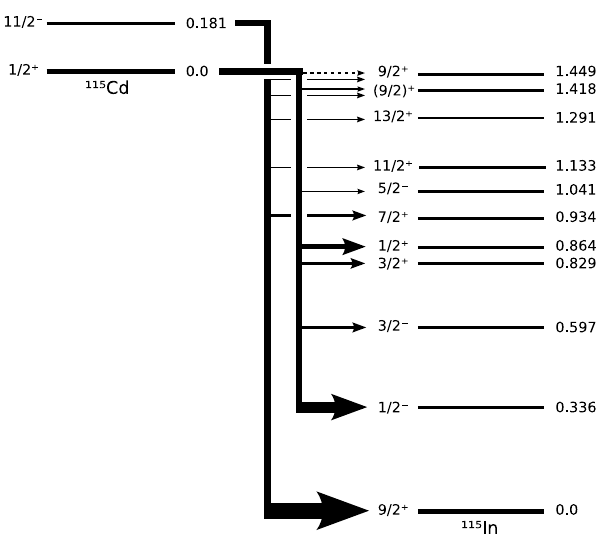
Figure 4. The β − decay scheme of 115 Cd. Shown are the decay transitions from the ground state and the isomeric first excited state of 115 Cd to states of the daughter nucleus 115 In with experimentally measured branching ratios. The dominant branches are indicated by thicker arrows. The dashed line shows the possible ultra-low-Q-value branch 1 / 2 + → 9 / 2 + . The numbers to the right of the energy levels are excitation energies in MeV.